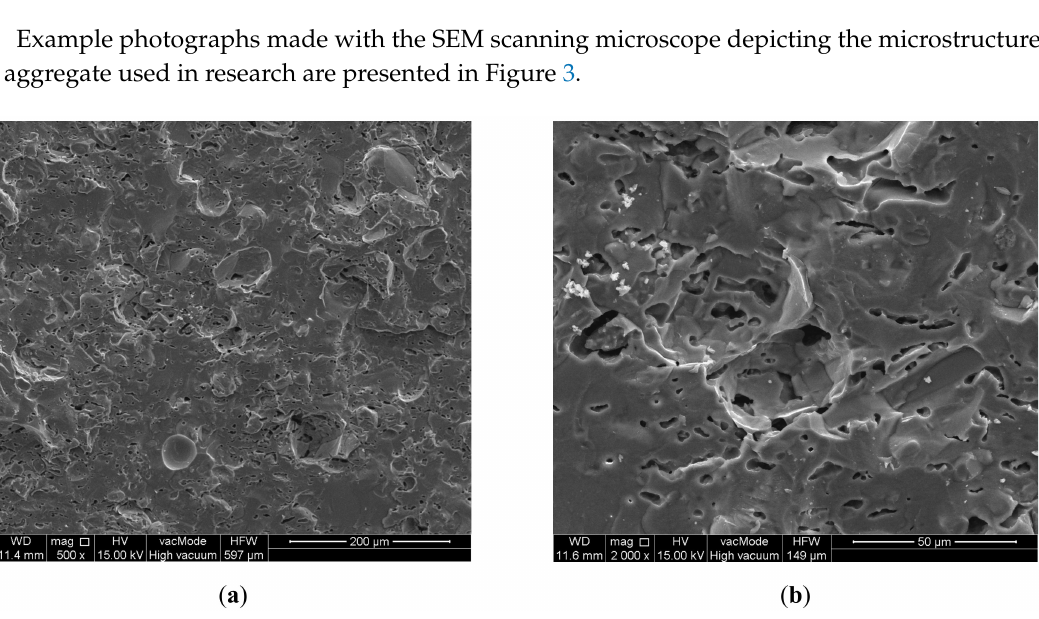
Figure 3. Micrographs of the aggregate (( a ) magnification 500 × , ( b ) magnification 2000 × ) used in research scanning electron microscope